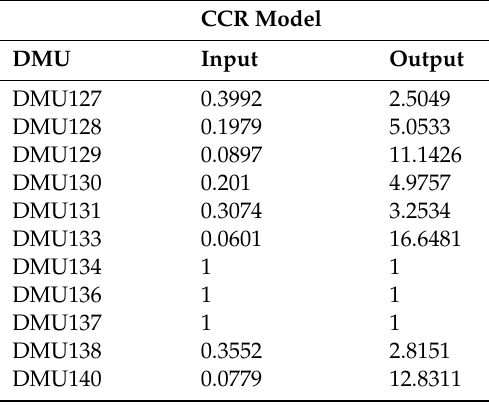
Table 8. CCR method for assessing the e ff ectiveness of PC, electronic and optical equipment